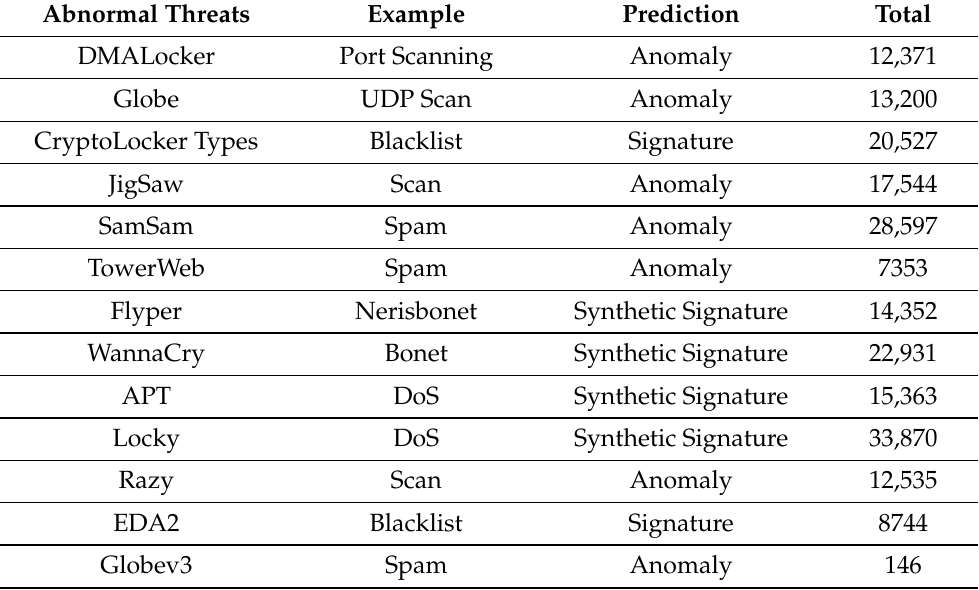
Table 3. The UGRansome1819 Data